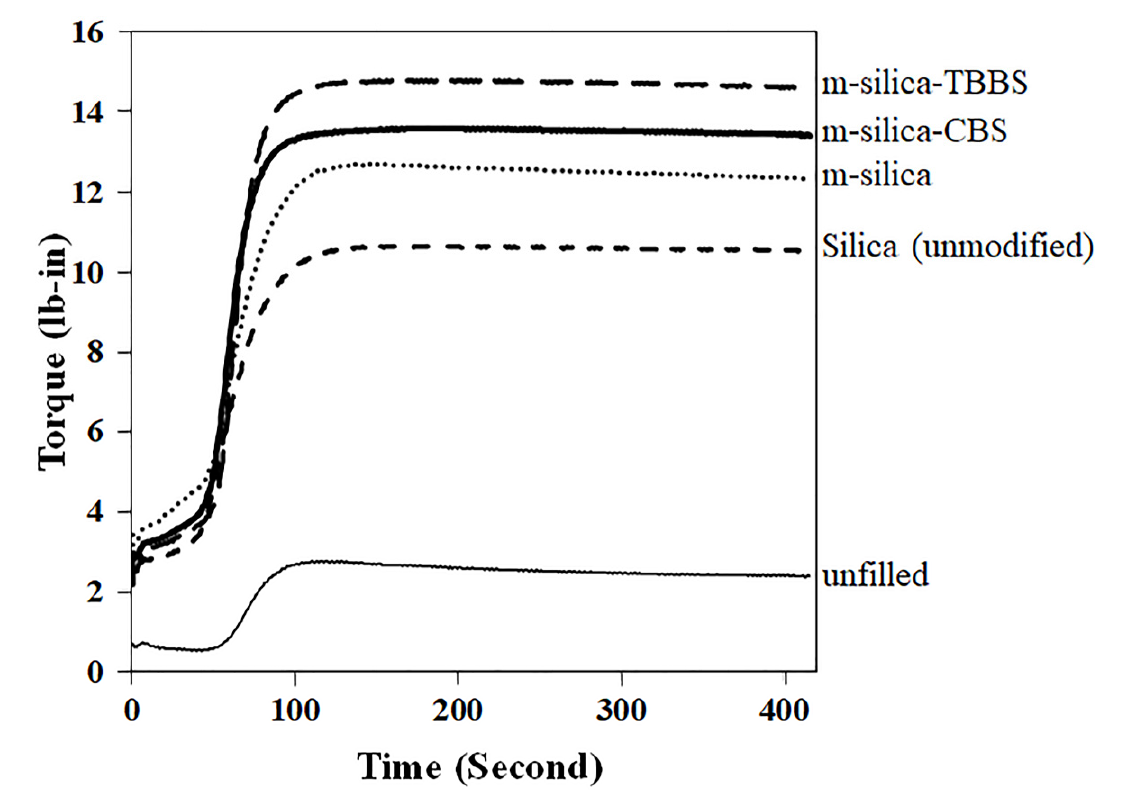
Figure 4. Cure curves of unfilled natural rubber and natural rubber filled with silica (unmodified), m-silica, m-silica-CBS, and m-silica-TBBS. Table 3. Cure characteristics of unfilled natural rubber and natural rubber filled with silica (unmod-